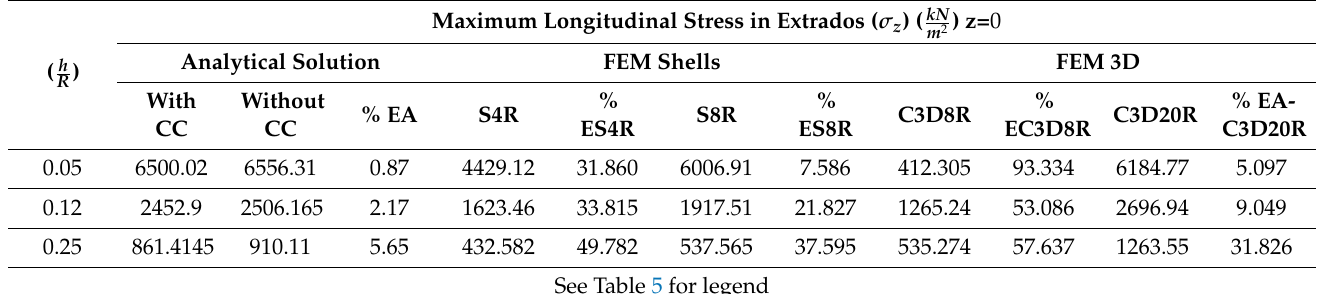
Table 7. Maximum longitudinal stress in extrados for different slenderness ratio.